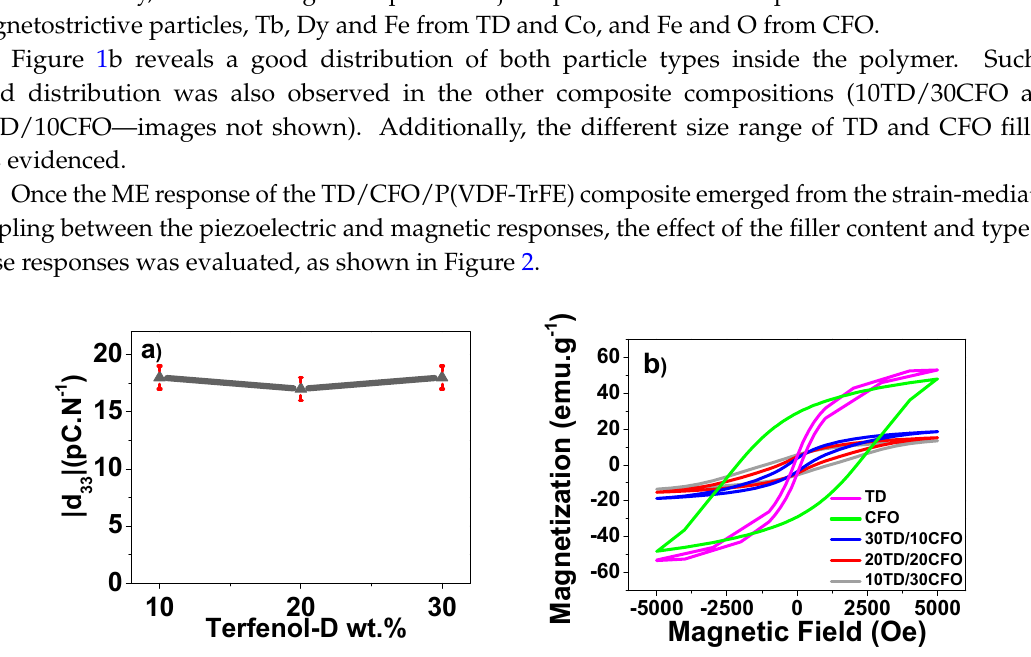
Figure 2. ( a ) Variation of the modulus of the piezoelectric response, the |d 33 | value, as a function of TD/CFO/P(VDF-TrFE) composite composition; ( b ) magnetic response of the TD/CFO/P(VDF-TrFE) composites.